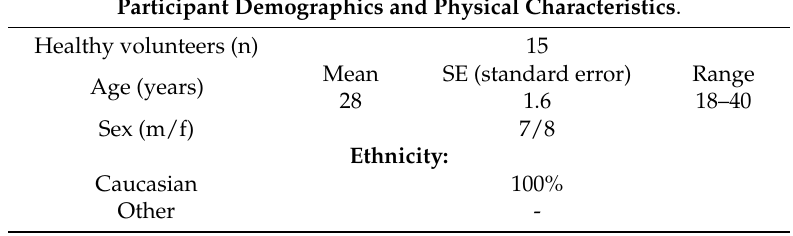
Table 3. Demographics and clinical data of the study subjects and H 2 S levels in the saliva samples obtained using fluorescence method with the compound 1